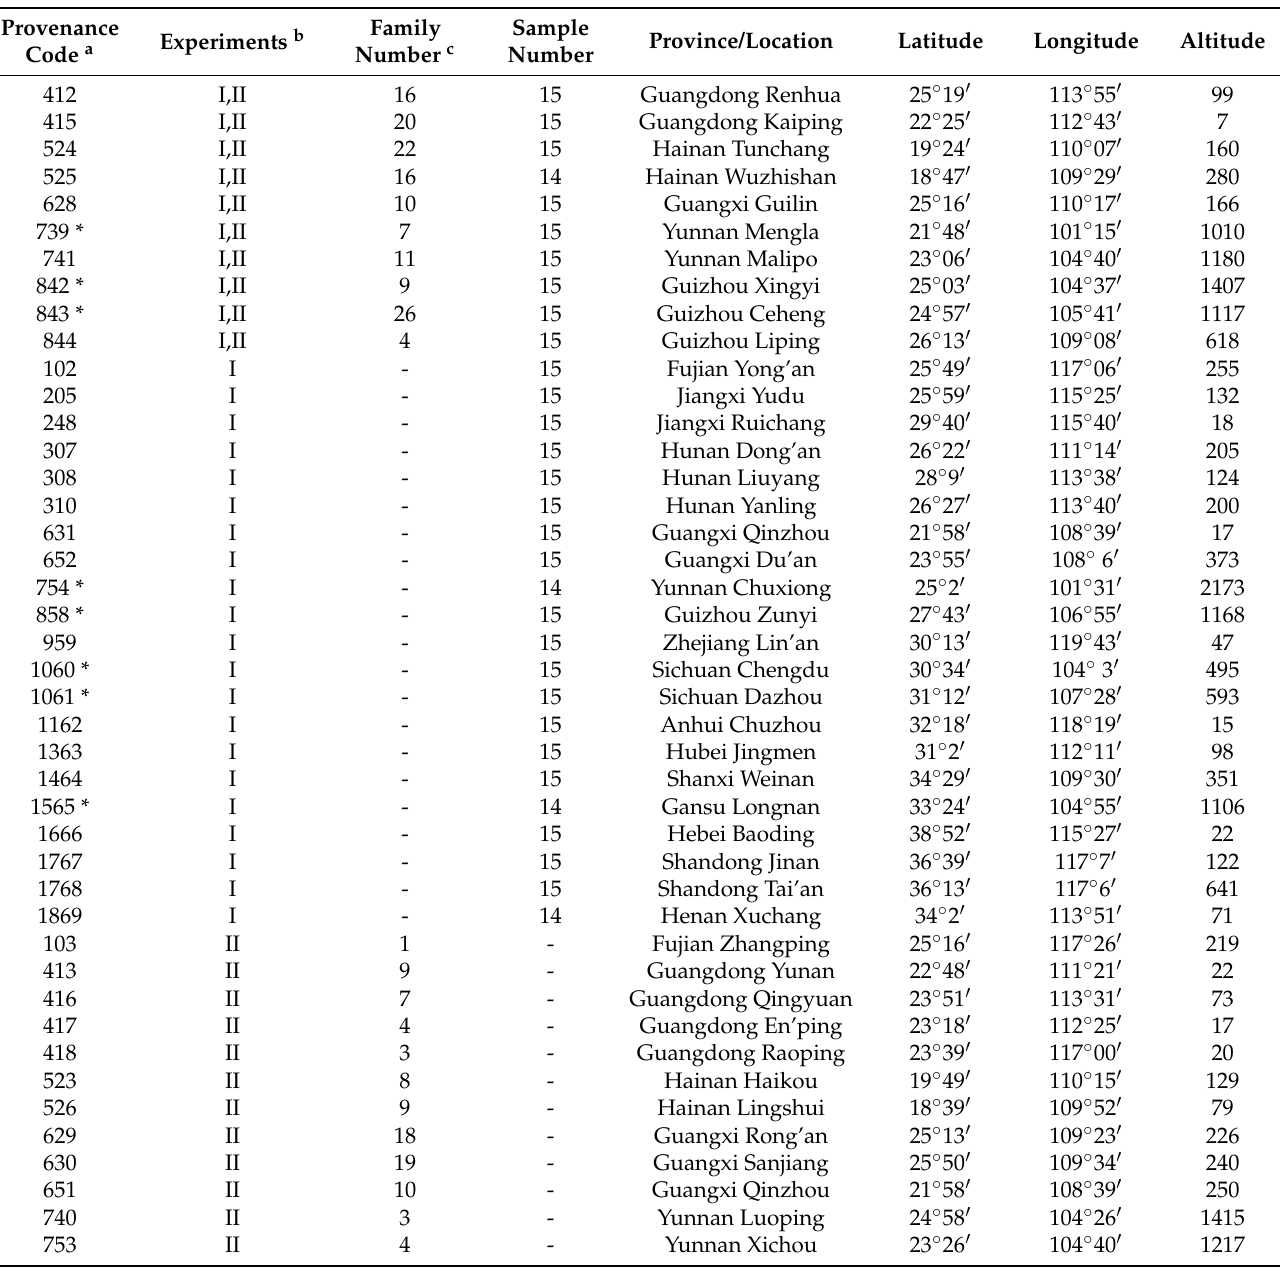
Table 1. Population information for this